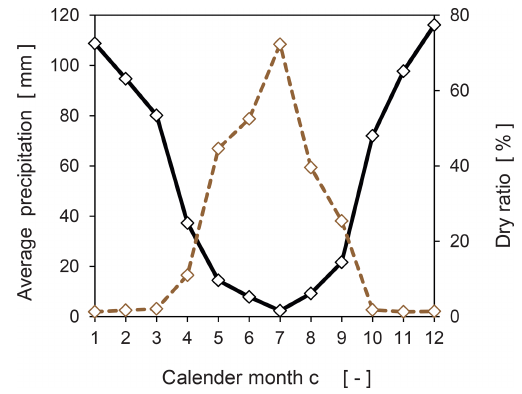
Figure 4. Average monthly precipitation (in mm) and dry ratio (in %) from 226 raingauges. Note that the dry ratio (dashed brown line) is indicated on the right